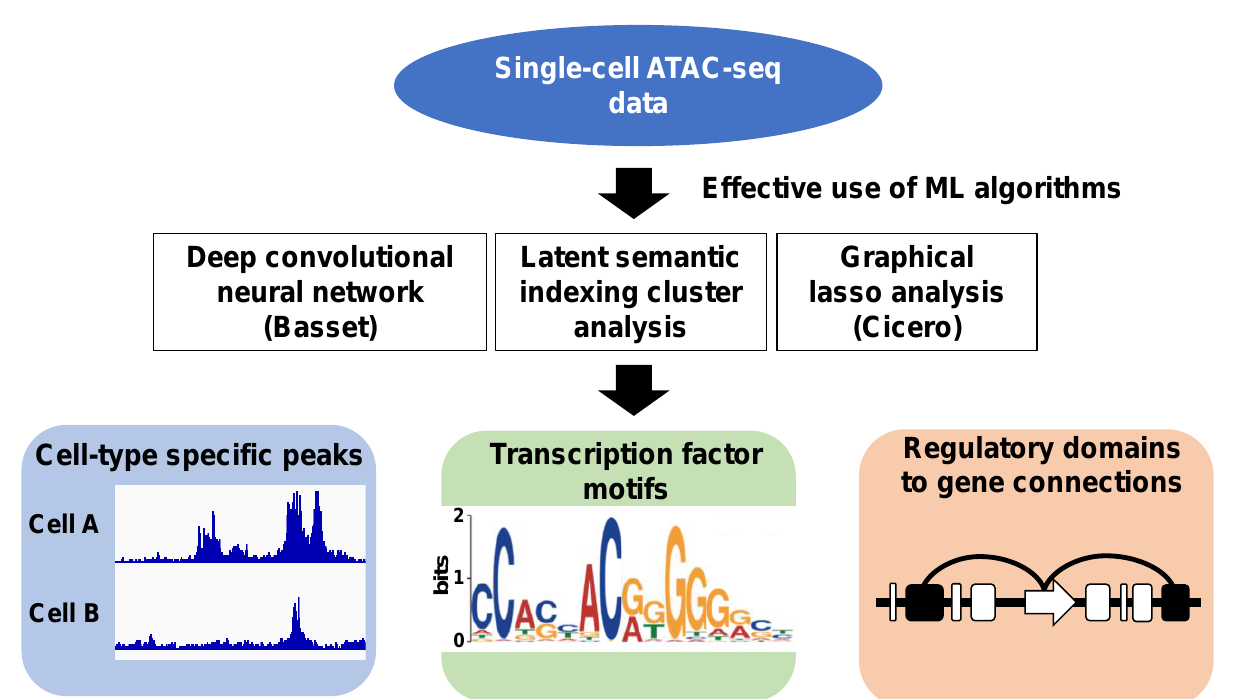
Figure 3. Schematic diagram of single-cell ATAC-seq analysis effectively leveraging ML. Basset is a deep convolutional neural network method to learn the functional activity of DNA sequences from genomics data. In particular, Basset allows us to simultaneously learn that cell’s chromatin accessibility code and annotate every mutation in the genome with its influence on present accessibility and latent potential for accessibility. Latent semantic indexing cluster analysis uses dimensional compression to normalize and cluster the data. Cicero uses a graphical lasso model to assign a regularized joint accessibility score, penalized by genomic distance, to each pair of “open” sites in each cluster. Hence, it is possible to find sites that were co-accessible in aggregated groups of cells within each cluster. By effectively using ML techniques in this way, we are able to predict cell clusters, transcription factors binding profiles, and cis-regulatory DNA elements (Reference [115]).